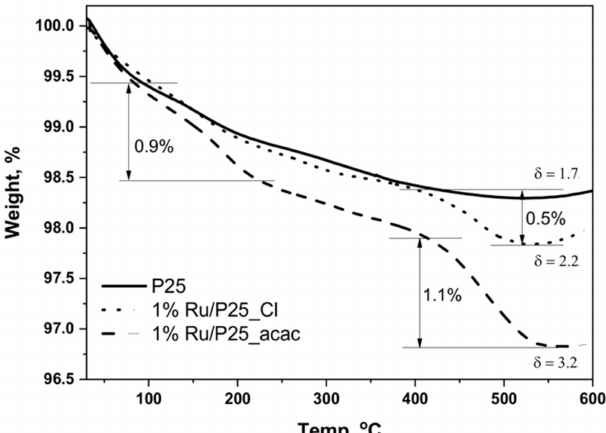
Figure 4. Thermogravimetric analysis (TGA) profiles of TiO 2 P25 and 1%Ru/TiO 2 materials